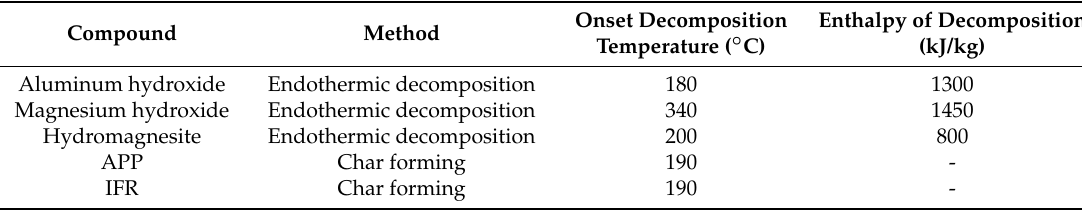
Table 2. Properties of tested flame retardant